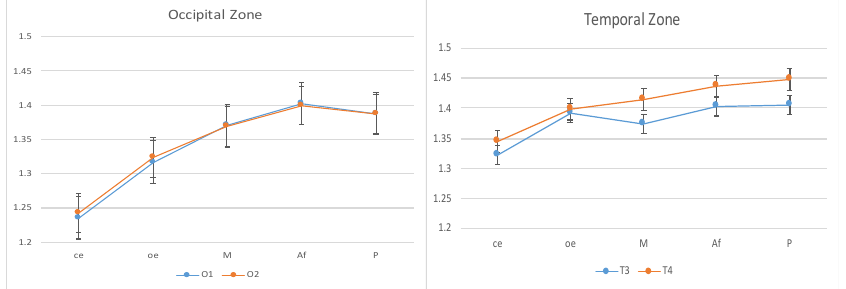
6 of 10 Figure 2. Average values of the fractal dimension in each electrode (F3, F4, O1, O2, T3, and T4) for the five types of EEG (closed eyes (ce), open (oe), Afghanistan-type driving (Af), Mali-type driving (M), and training track (P)).